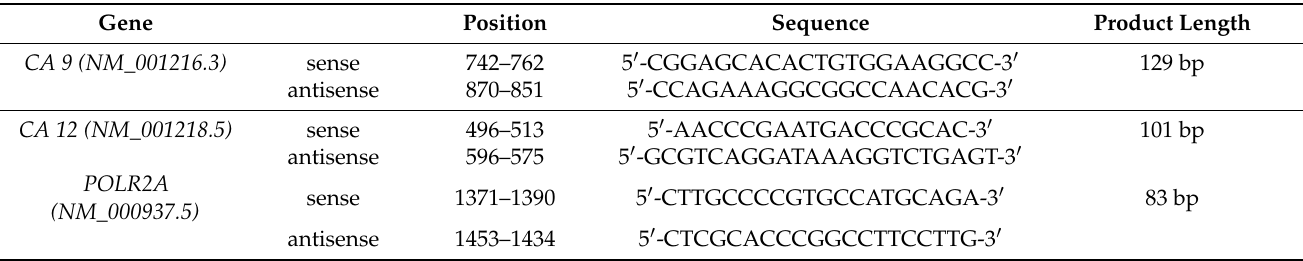
Table 2. PCR primer